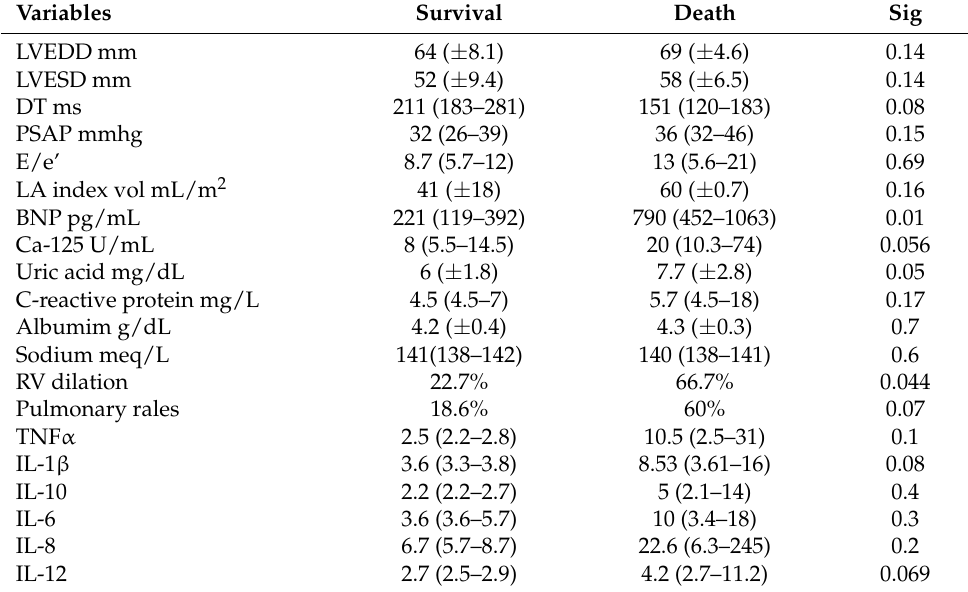
Table 3. Echocardiography, laboratorial and clinical variables and survival.